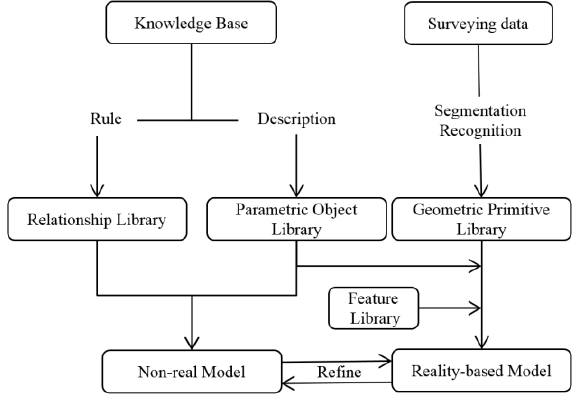
Fig. 4: The historic building modelling